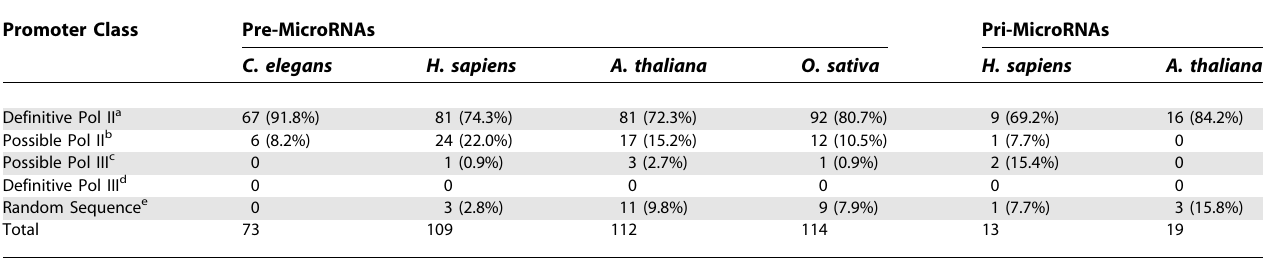
Table 6. Classification Results of MicroRNA Genes Using the Known Pre-MicroRNAs and Pri-MicroRNA Promoter Class